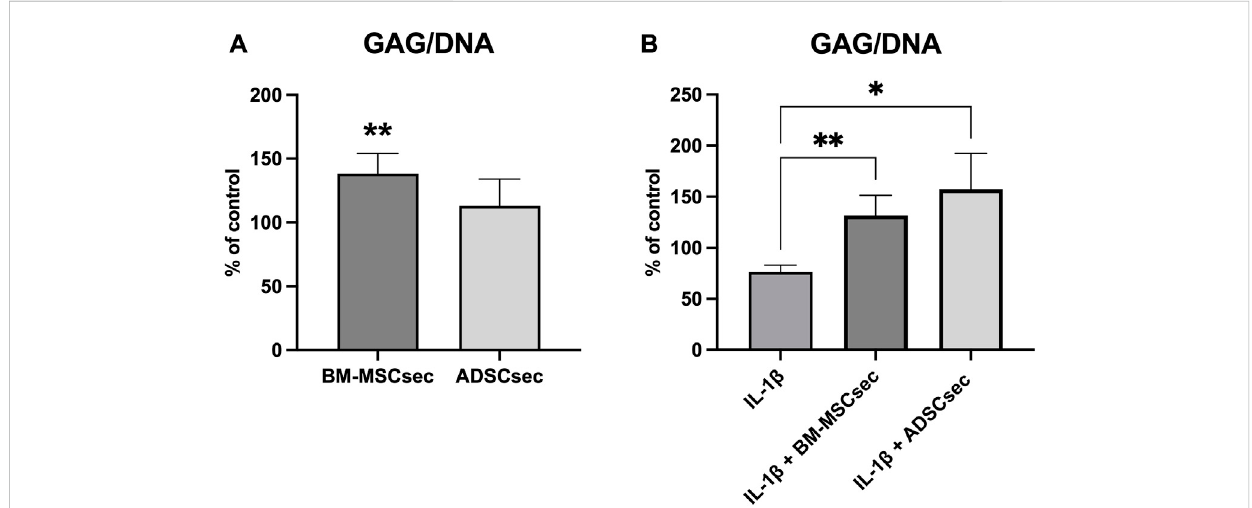
FIGURE 6 BM-MSCsec increased GAG content in treated hNPCs. (A) GAG/DNA ratio in hNPCs after MSC secretome treatment demonstrated a signi fi cant increase in the group treated with BM-MSCsec. (B) Following IL-1 β pretreatment, both BM-MSCsec and ADSCsec demonstrated to rescue GAG/DNA levels compared to the group treated with IL-1 β only. Data are expressed as GAG/DNA ratio percent variation between the control and experimental groups. * p < 0.05, ** p <